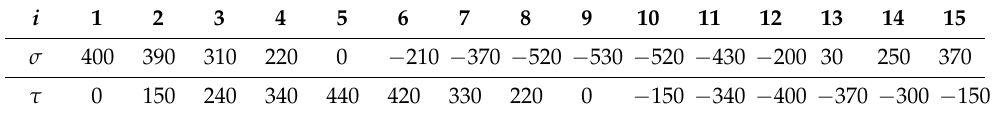
Table 4. Experimental data of the initial transformation onset of Ni–Ti SMA at 50 ◦ C (unit: MPa). i